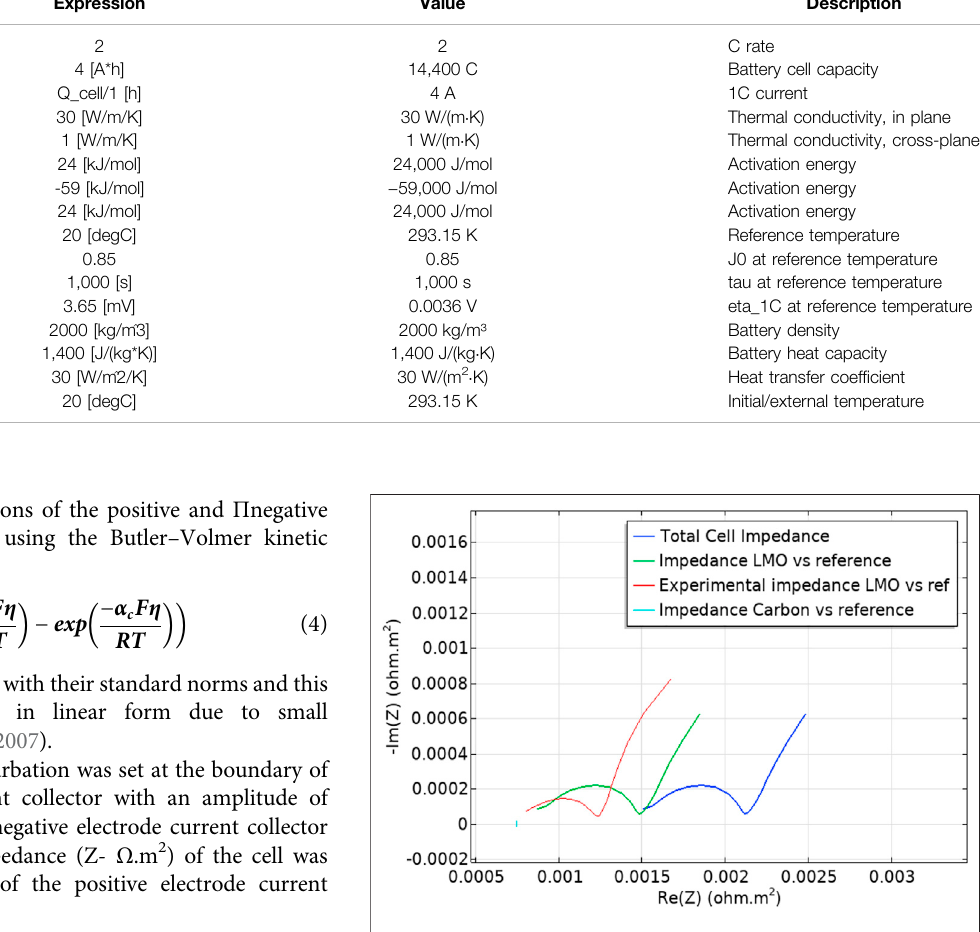
FIGURE 8 | Nyquist spectra